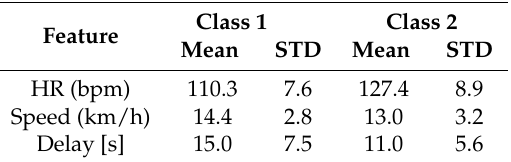
Table 2. Comparison of means and standard deviations (STD) of selected cycling features (heart rate (HR), speed, and the delay in the change in the heart rate vs. gradient of altitude) for classification